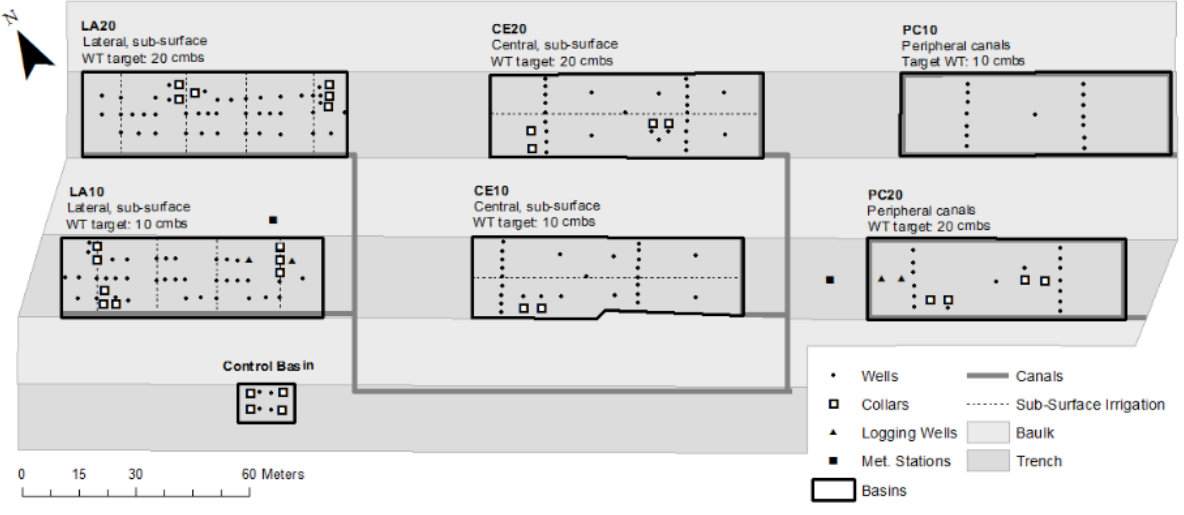
Figure 1 . Bog 530 study site, Shippagan, NB, Canada. centre, denoted as CE10 and CE20, CE for